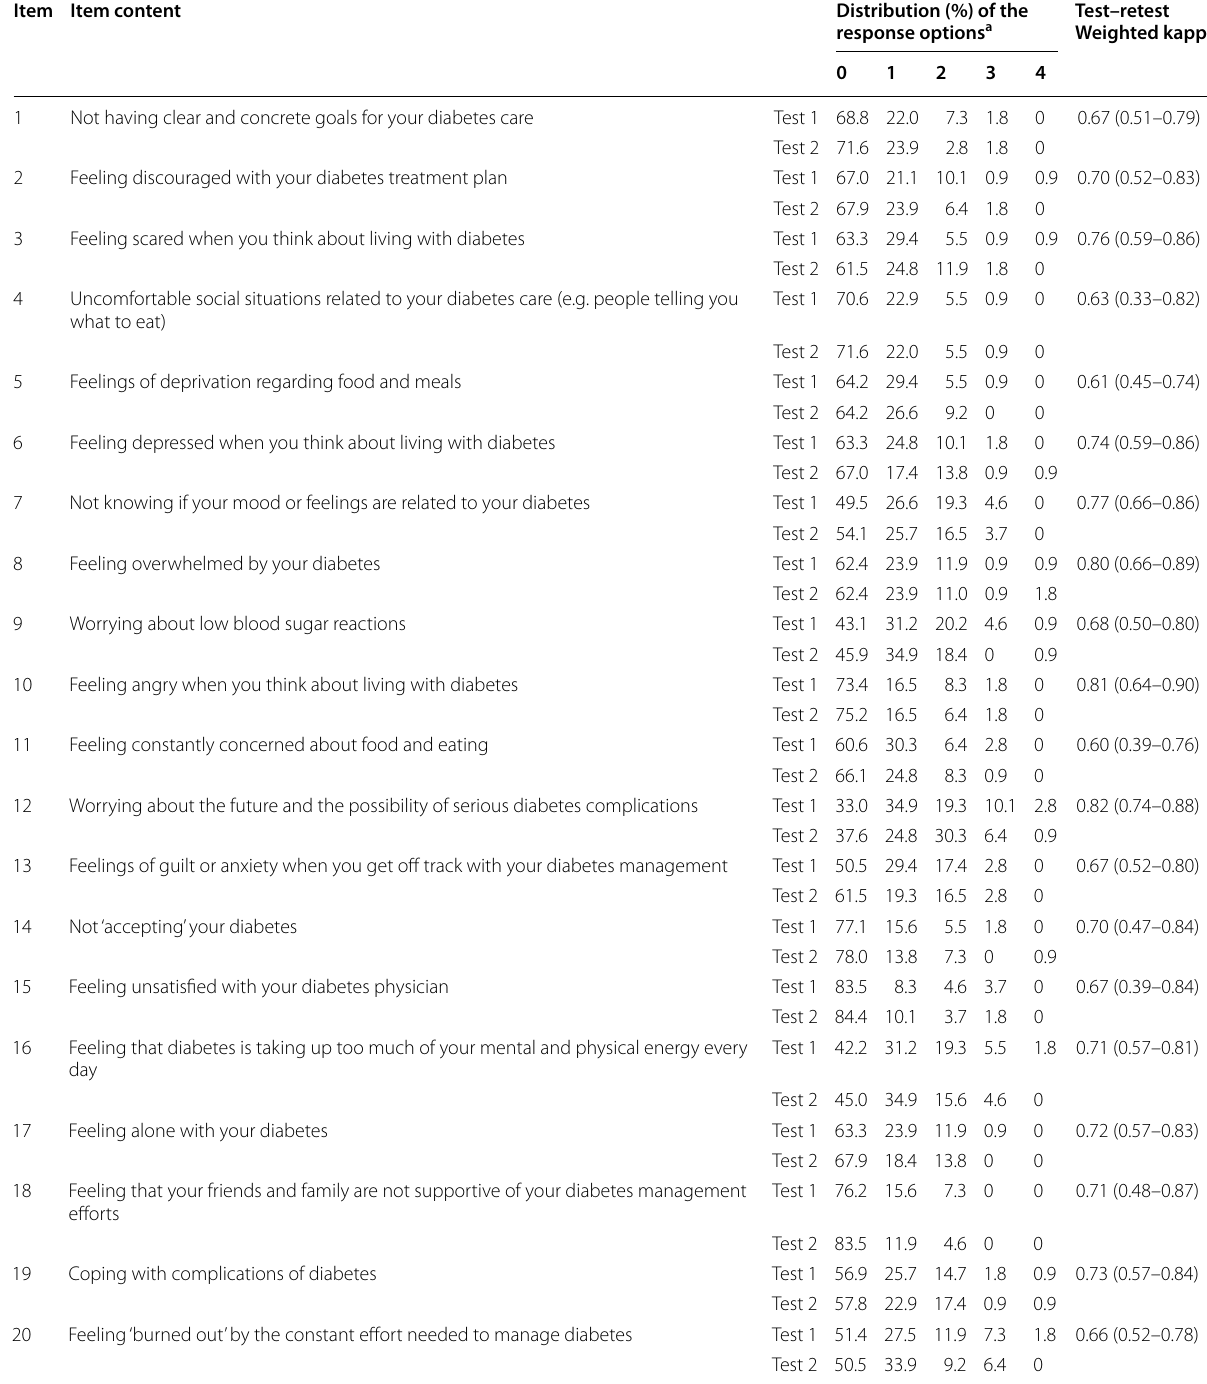
Table 3 Item level distribution and weighted kappa of the Problem Areas in Diabetes (PAID) questionnaire among 108 patients with type 1